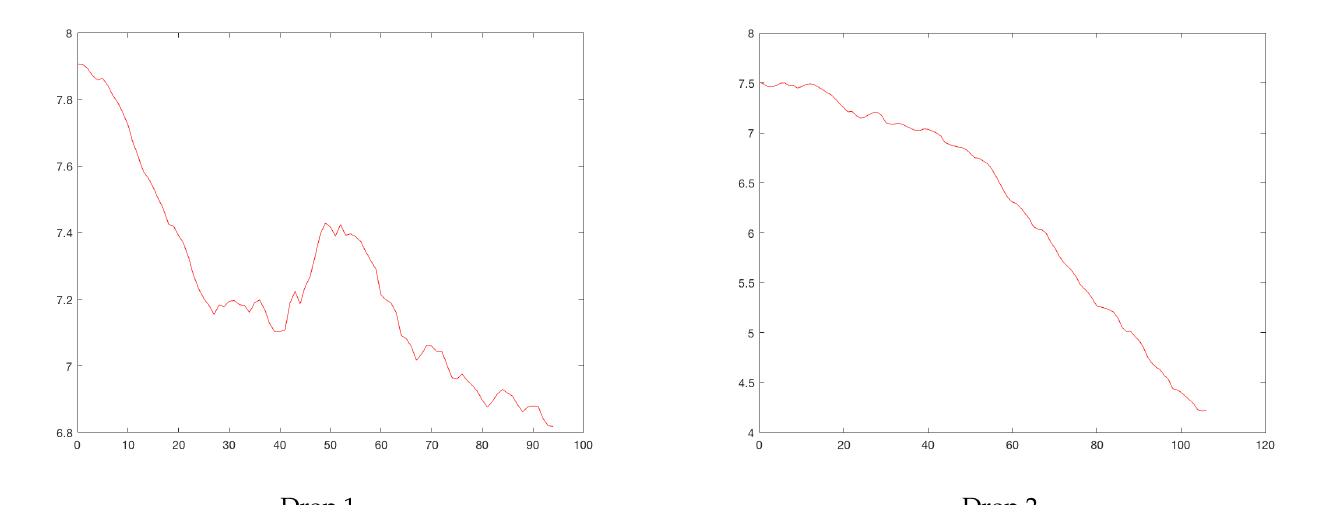
Drop 1 Drop 2 Figure A31. Roma’s drops. Horizontal axis, days; vertical axis: logarithm of daily